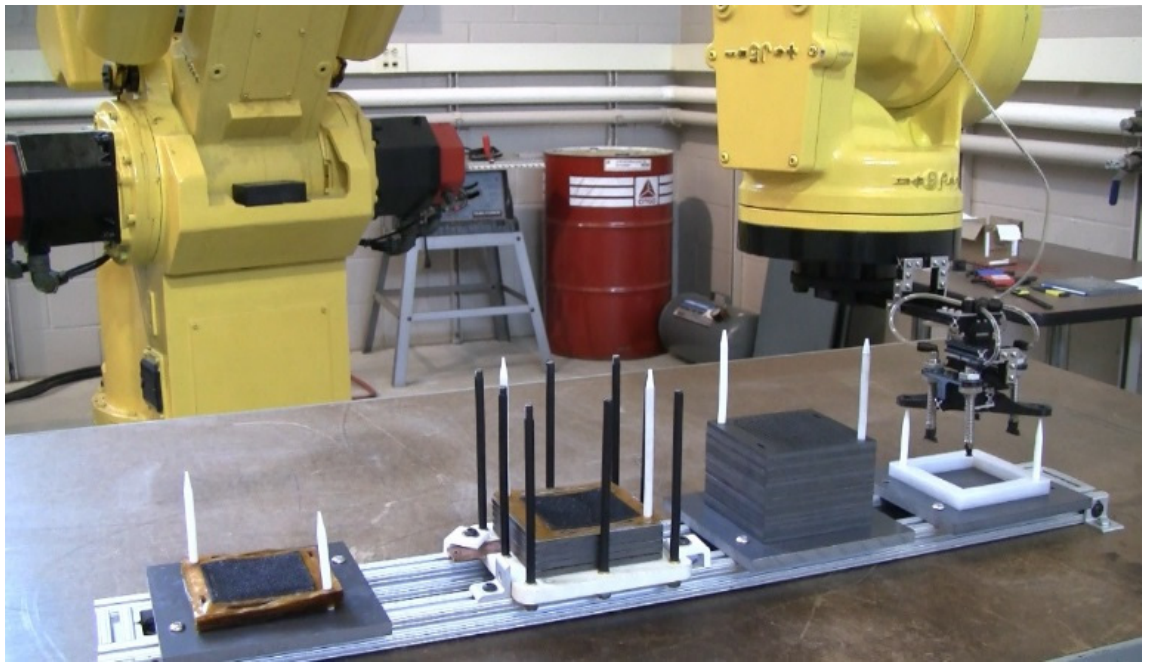
Figure 5. The assembly workcell consisting of one Fanuc S 420F robot and a framing attached to the workbench on which the fuel cell endplate (second from left) and three polyvinyl chloride (PVC) plates from where the membrane electrode assemblies (MEAs) (first from left), the bipolar plates (third) and gaskets (fourth) are picked from are securely mounted. A new fuel cell endplate is placed on the frame every time a new stack is built. The endplate is positioned on the frame using locators and